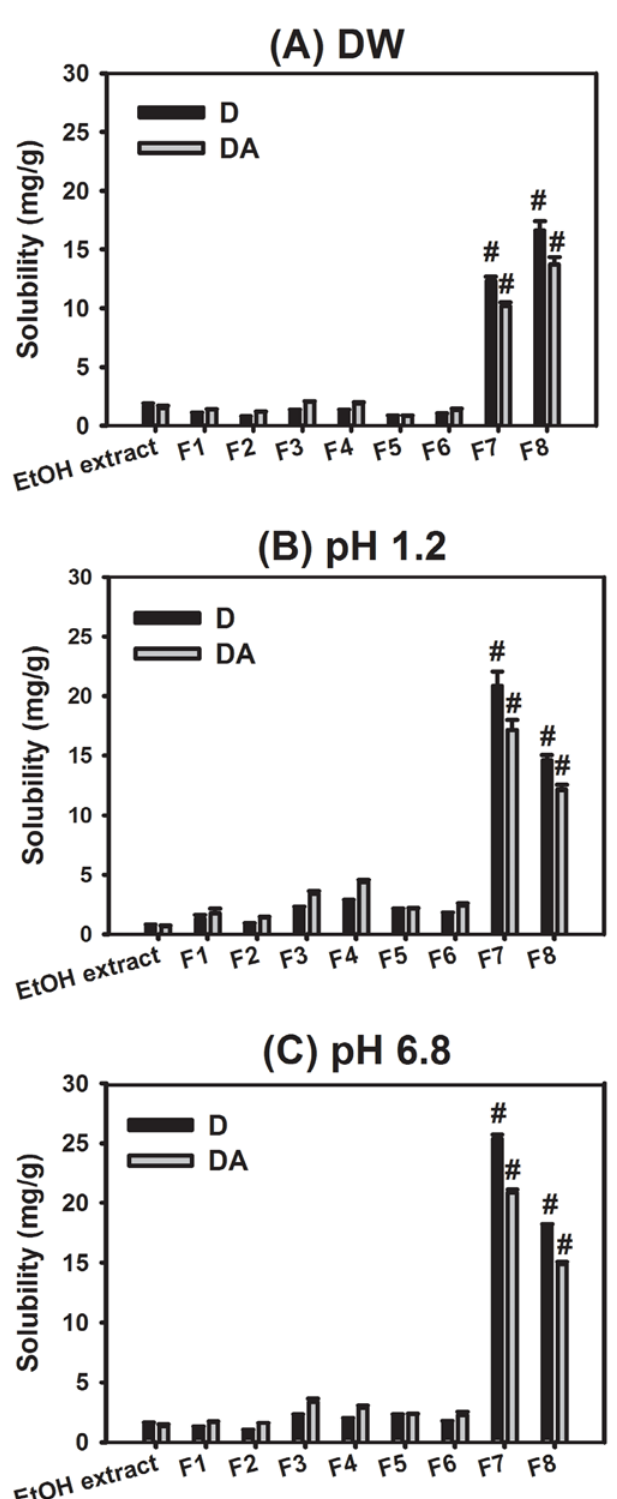
Fig 4. Released amounts (mg/g, w/w) of D and DA in DW (A), pH 1.2 (B), and pH 6.8 (C). Data are presented as mean ± SD (n = 3). # p < 0.05, compared to D or DA in AGN EtOH ext group. Two-tailed t -test is used for the statistical